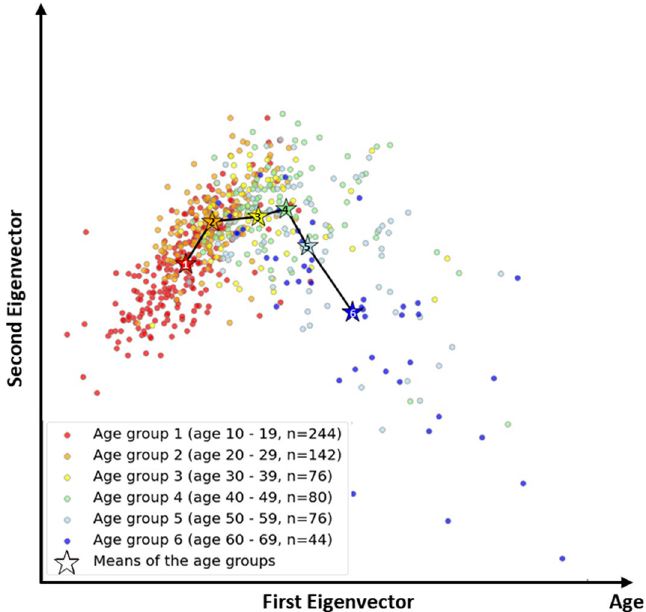
Figure 4. Original 18-dimensional data projections mapped into the 2D space learned from Fisher discriminant analysis. Horizontal and vertical axes are the first and second eigenvectors, where the horizontal axis represents age. The black line concatenating the means of the six groups clearly reveals their chronological order, which supports our data, i.e., embedded age information. The means of the groups are denoted as stars with the group